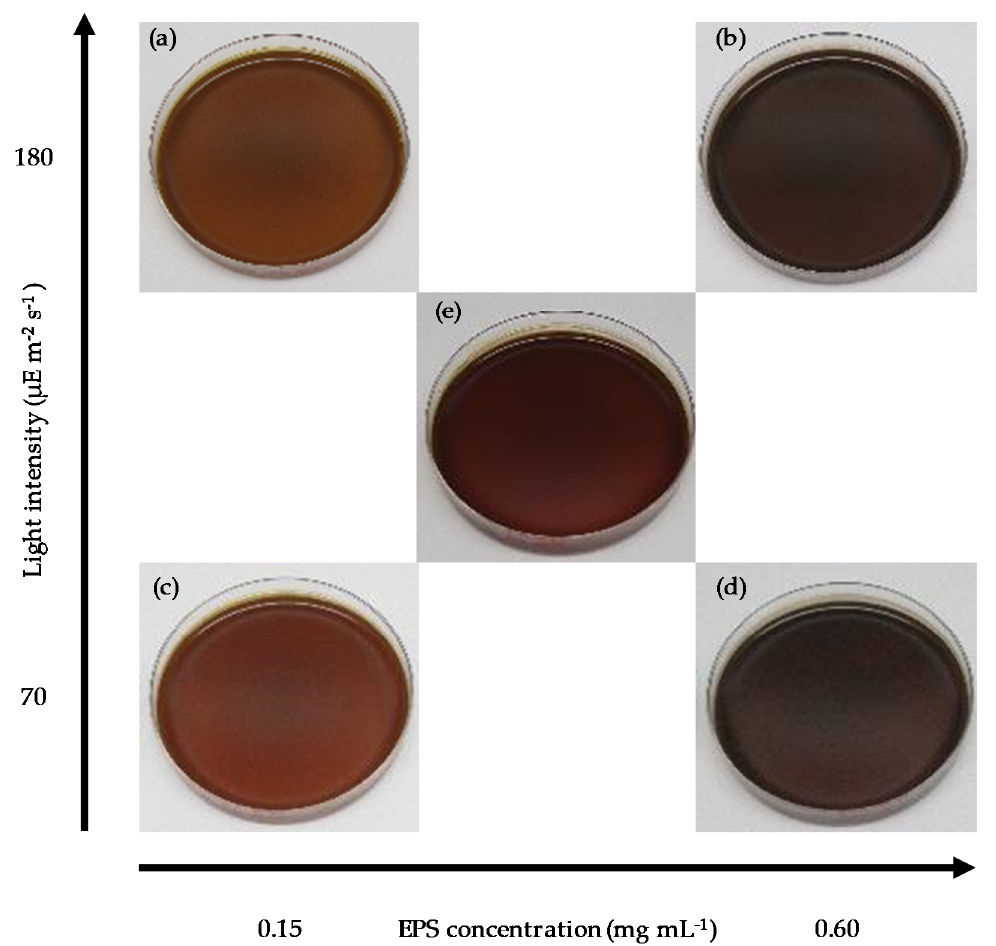
Figure 4. Digital images of samples: ( a ) EPS-0.15-1 mM-180 µ E; ( b ) EPS-0.60-1 mM-180 µ E; ( c ) EPS-0.15-1